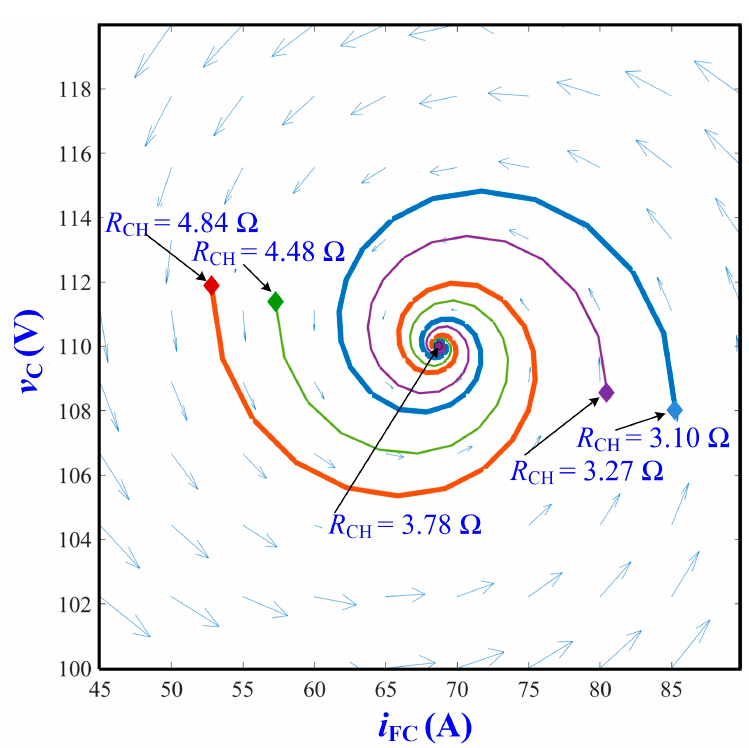
Figure 4. Simulation results: constant resistive loads (CRL) step from 5.00 Ω to 3.78 Ω of the 2-phase FC boost converter with the open-loop control at a constant duty cycle d = 0.5767 (the FC boost converter parameters are expressed in Table A1).